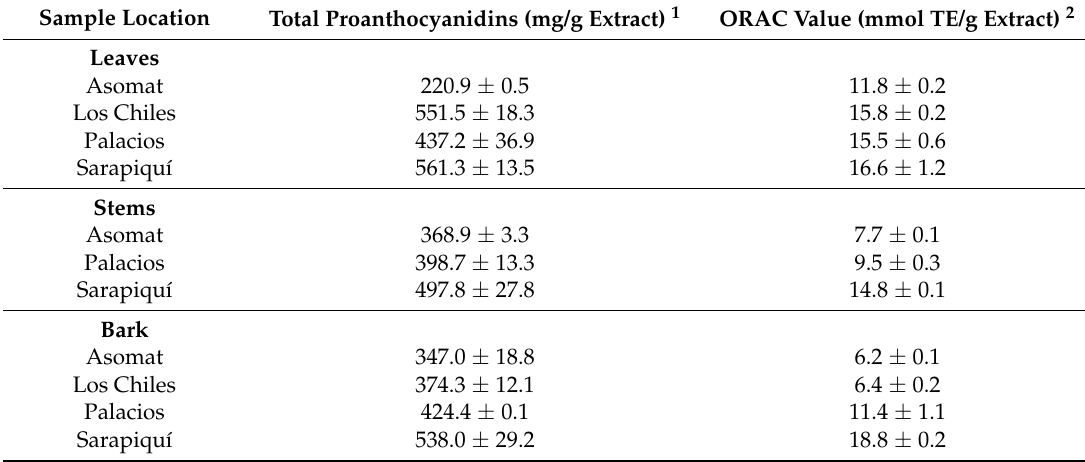
Table 1. Total proanthocyanidins and antioxidant activity of leaves, stems, bark and wood extracts from U. tomentosa